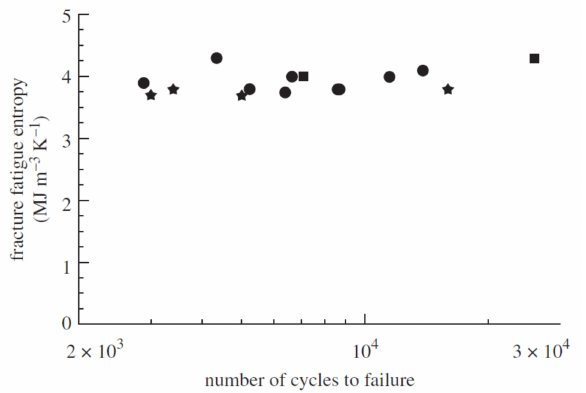
Figure 1. Experimental fracture fatigue entropy versus the number of cycles to failure for tension- compression, bending, and torsional fatigue tests of Al 6061-T6 at frequency 10 Hz [86].This picture is ©2009 The Royal Society.